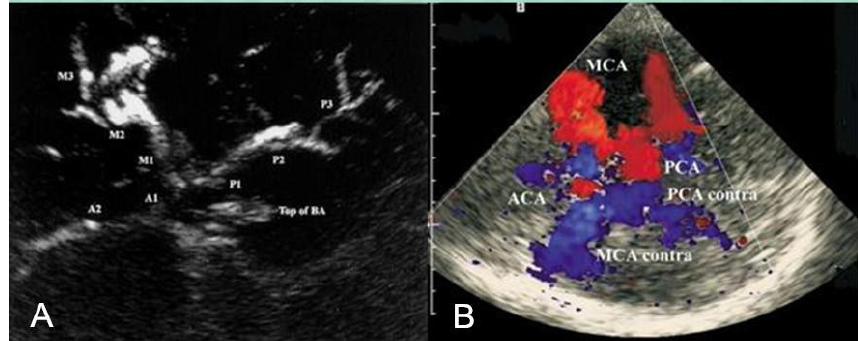
Figure 3 - A. tUSA image of the circle of Willis and its branches after injection of ultrasound contrast agents. M1, M2, M3=middle cerebral artery segments; A1, A2=anterior cerebral artery segments; P1, P2, P3, P4=posterior cerebral artery segments; BS=brainstem; Top of BA=hyperechogenic distal part of the basilar artery. B. Contrast-enhanced transcranial ultrasound of the circle of Willis (axial scanning plane via the temporal bone window). Vessel delineation is diminished because of the strong contrast signal (“blooming”) after IV bolus injection of UCA. MCA=middle cerebral artery; MCA contra=middle cerebral artery contralateral; PCA=posterior cerebral artery; PCA contra=posterior cerebral artery contralateral; ACA=anterior cerebral artery.